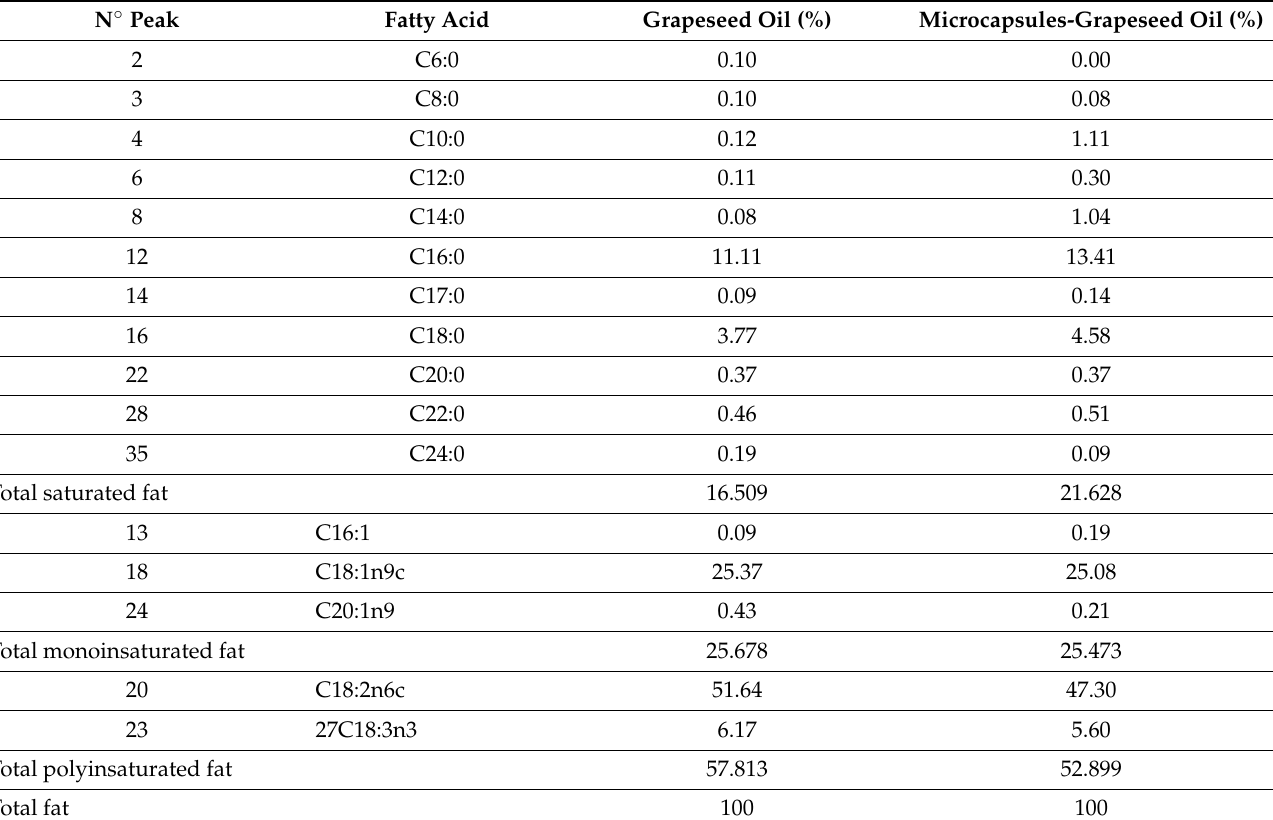
Figure 5. Fatty acid gas chromatographic profiles; left: grapeseed oil; right: grapeseed oil microcapsules. Table 2. Fatty acid profiles of grapeseed oil, encapsulated and